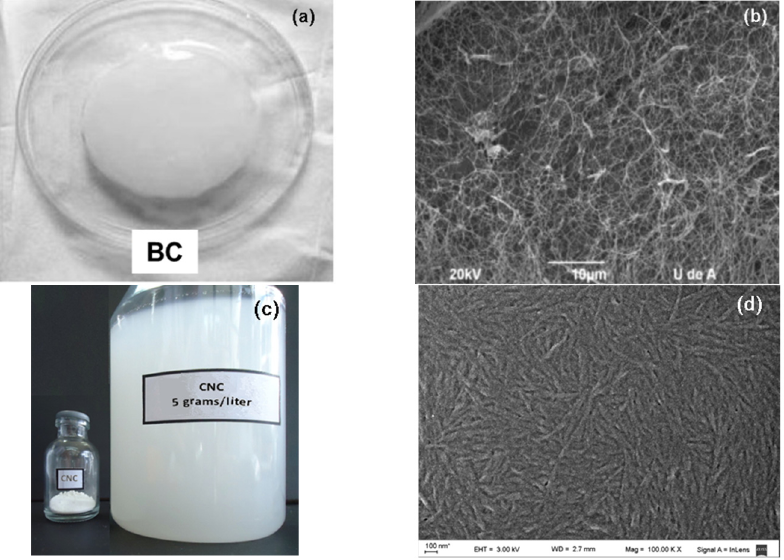
Figure 2. ( a ) Digital image of the wet BC membrane; ( b ) SEM image of the same sample after being lyophilized; ( c ) digital image of CNC powder and water dispersion; ( d ) field emission scanning electron microscopy (FE-SEM) image of the electron microscopy (FE-SEM) image of the CNCs.